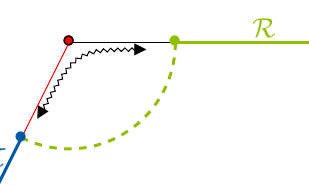
Figure 1: A cartoon depiction of the setup, with the brane in red, the bath in black, and the interface represented as a dot. The two-headed arrow indicates transparent boundary conditions. By computing the entanglement entropy of the radiation region R , the island rule demands that we also minimize over possible regions on the brane I . Classically in (III), we end up with the I for which the entanglement surface area (possibly including brane-action contributions) is